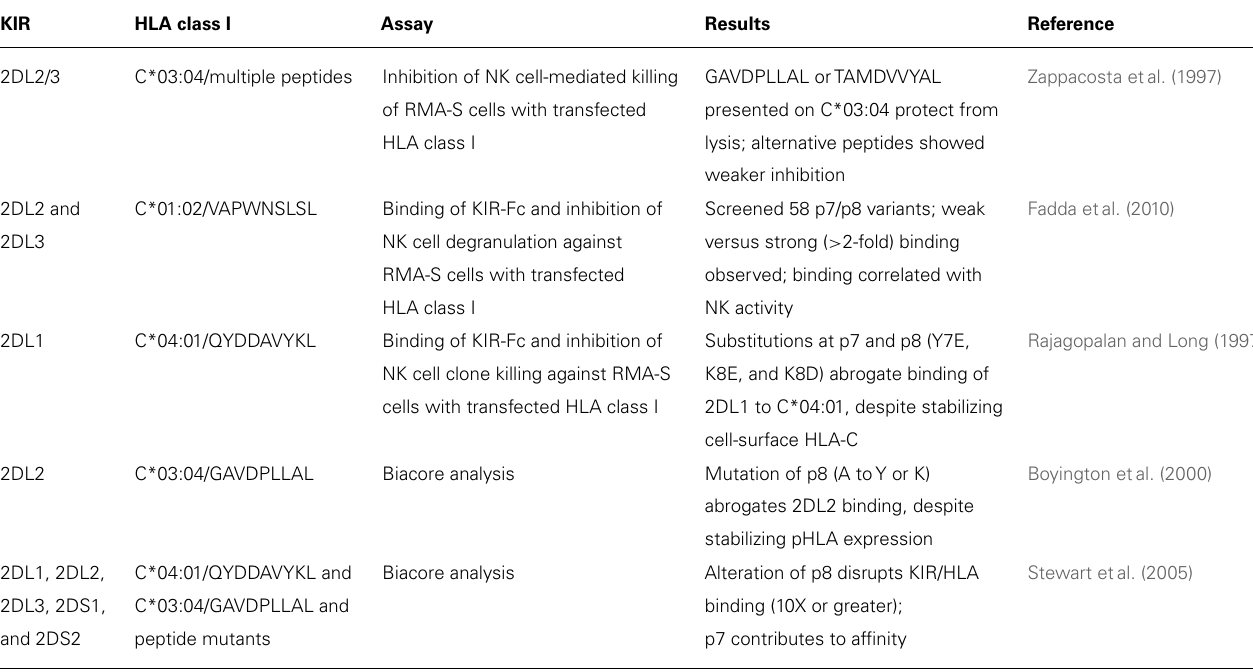
Table 6 | Effects of the bound peptide on the interaction of KIR with